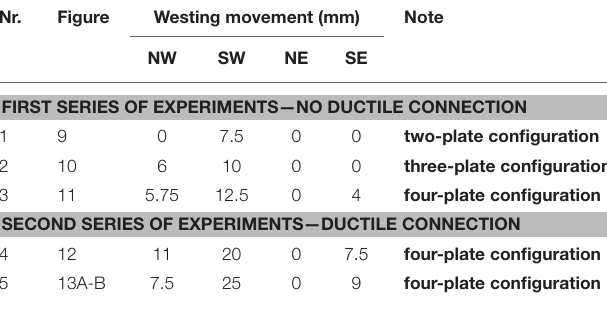
TABLE 2 | List of experiments done in the present work.